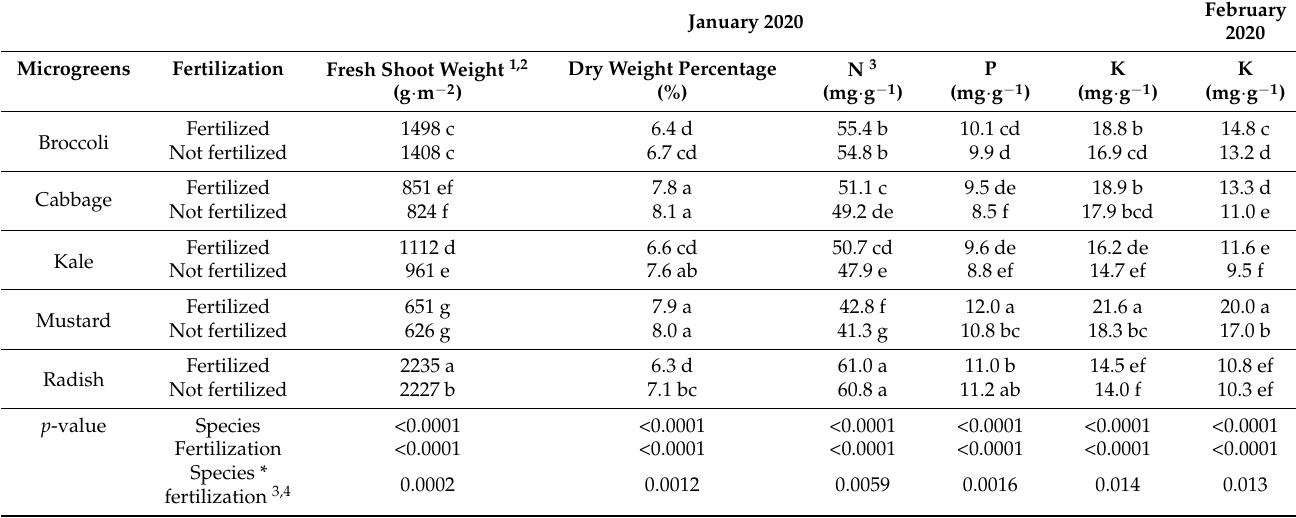
Table 6. Fresh shoot weight, dry weight percentage, and macronutrient concentrations in five microgreens affected by the interaction between species and post-emergent fertilization treatment in January or February 2020.